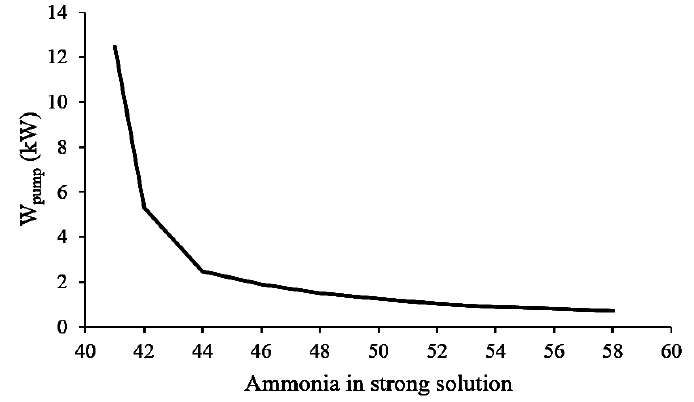
Figure 4. Effect of X ss on circulation ratio (CR) and cut in/off temperature.